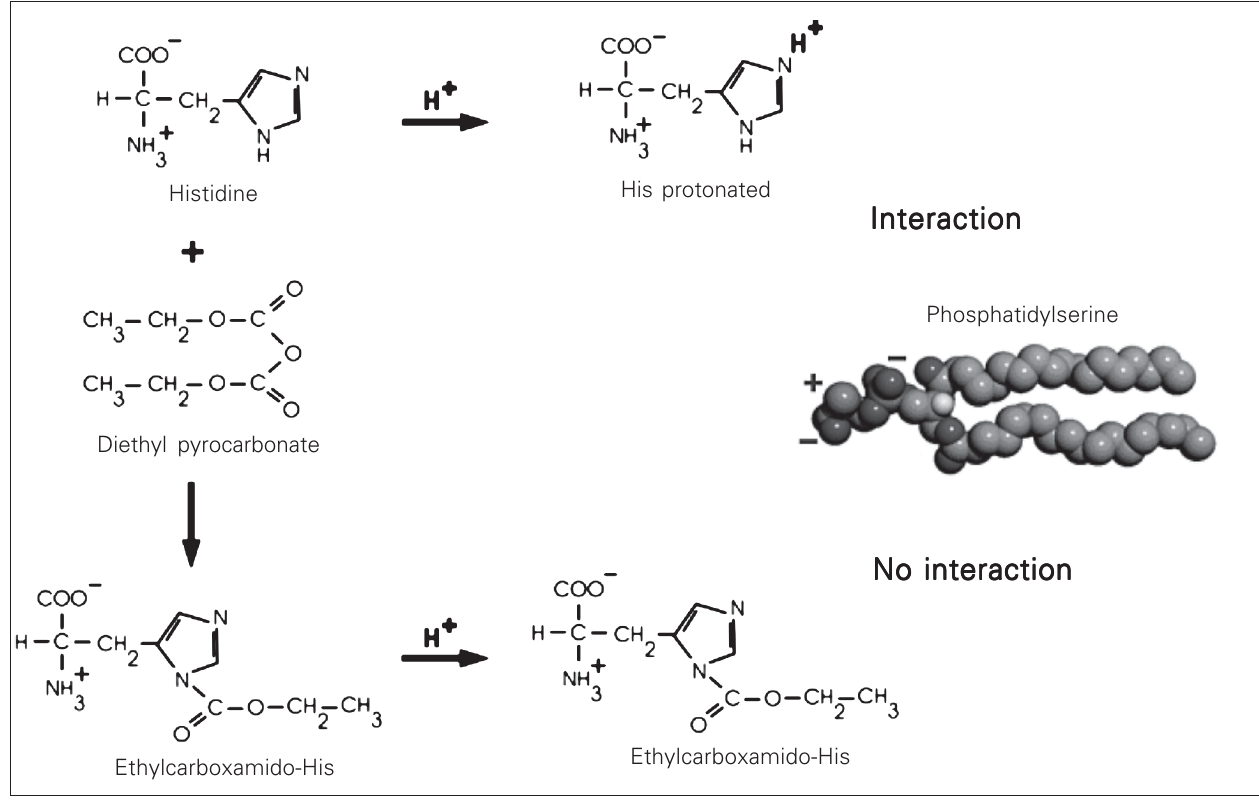
Figure 3. Role of His protonation in rhabdovirus-induced membrane fusion . His modification with diethyl pyrocarbonate (DEPC) abolishes pH-induced conformational changes in G protein and also the fusion reaction catalyzed by the virus. As demonstrated in this figure, treatment of vesicular stomatitis virus with DEPC impairs His protonation, which seems to be necessary for the interaction between G protein and the negative charges conferred by phosphatidylserine to the target